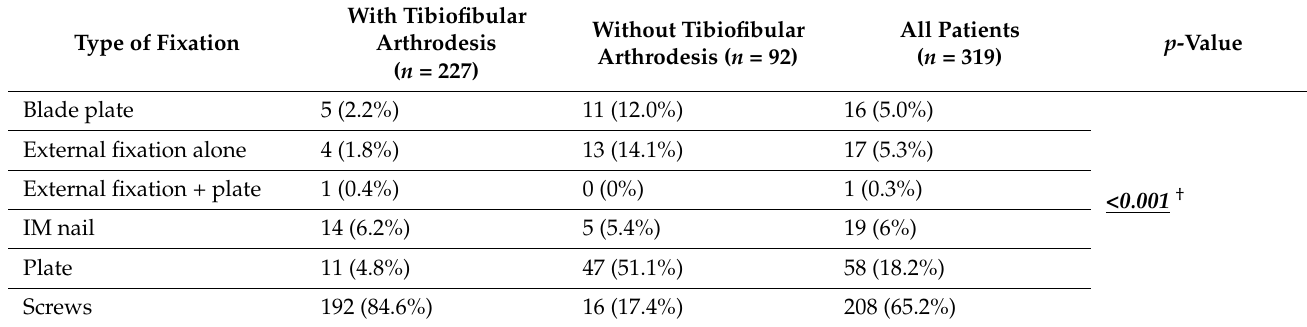
Table 4. Type of fixation.